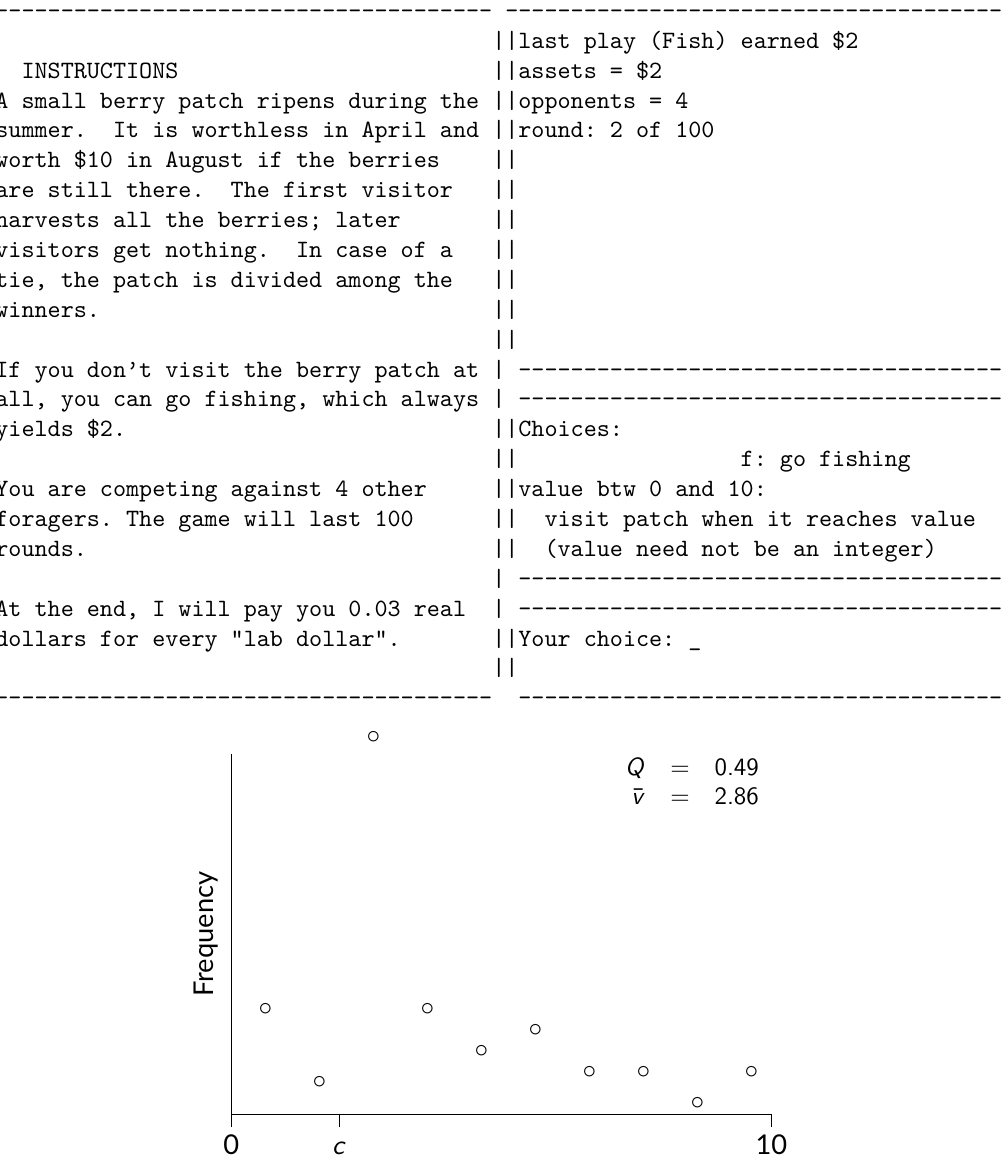
Figure 1 – Computer screen used in berry patch